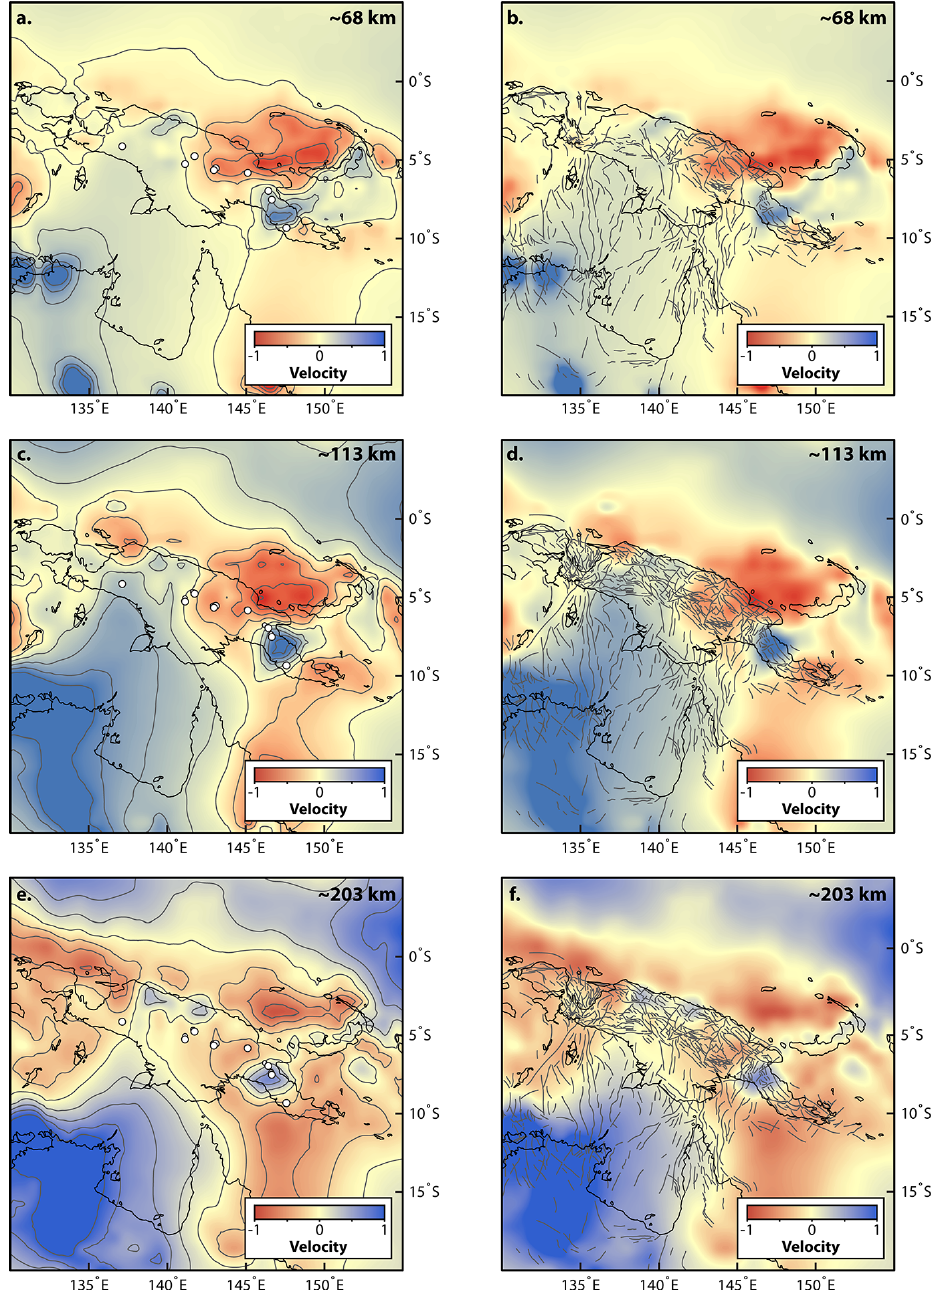
Fig. 11. Seismic tomograms were generated for the New Guinea region from a global P wave tomography data set (Li et al., 2008). Here we show slices at different depths: (a–b) 68km; (c–d) 113km; and (e–f) 203km. The images that are shown in the left-hand column (a, c, e) have been contoured and also show the location of the Au/Cu/Ag/Mo deposits (white circles) that are described in Fig. 1a. The images that are shown in the right-hand column (b, d, f) compare the tomography data with the lineament interpretation that is shown in Fig. 9. There is some similarity between the orientation of some lineaments and the tomographic “anomalies”. These tomography data also indicate that there is a keel of cold Australian lithosphere below much of western New Guinea. This possibly represents a rigid indentor. The Grasberg, Frieda River, Nena, Star Mountain and Ok Tedi deposits are located at the margins of this tomographic feature. This might indicate that the edges of the keel have influenced the location of faults in crust, and therefore helped to concentrate the deposition of metalliferous fluids/magmas.